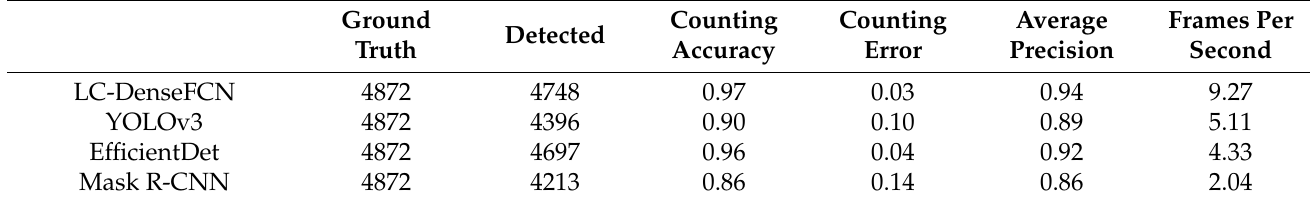
Table 2. Comparison of counting results with three competing methods.